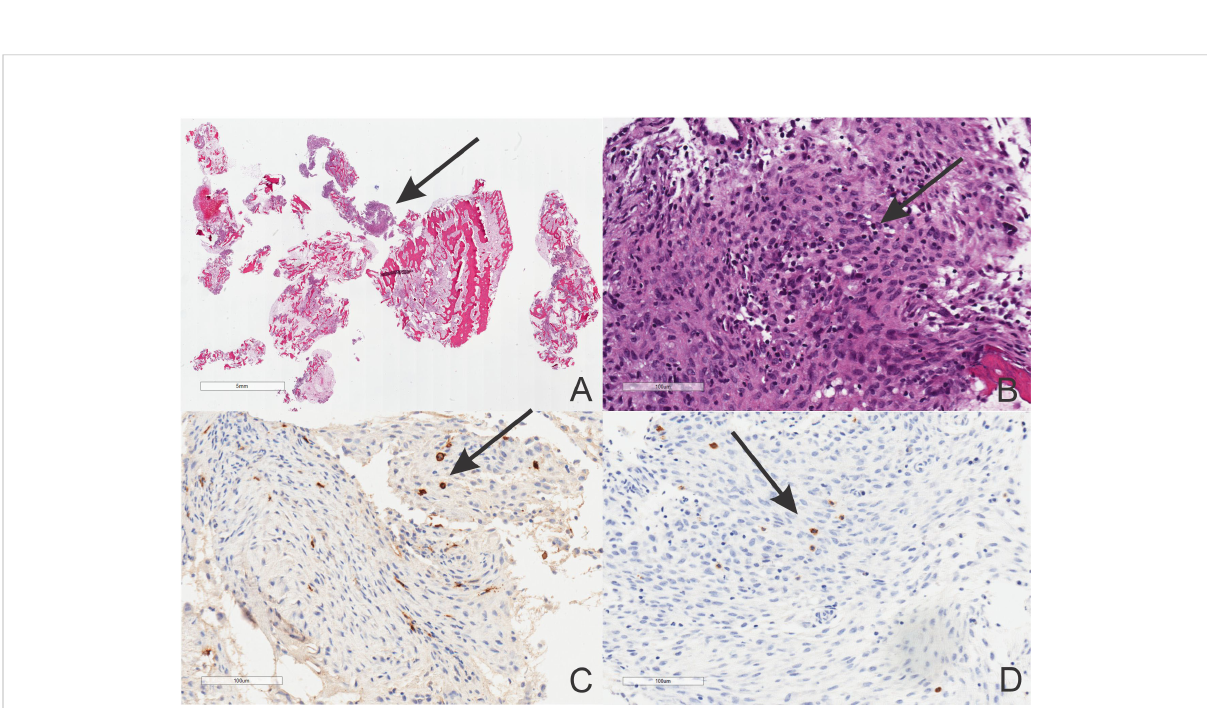
FIGURE 3 Histopathology of the CRMO showing low and high power magni fi cation of a nonbacterial osteomyelitis ( A, B , hematoxylin-eosin staining, scale bars included) with CD117 (C) and tryptase (D) positivities (Avidin-Biotin Complex immunostaining, scale bars